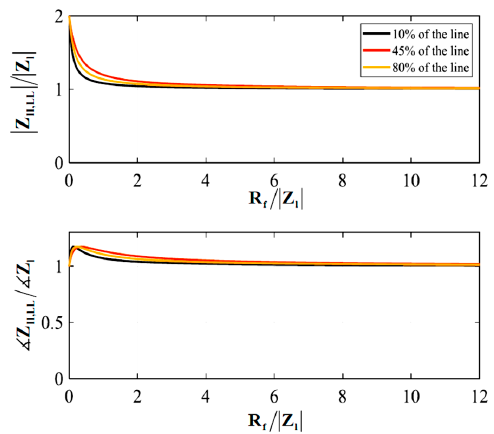
Figure 8. R f -Z I,LL curve for several fault location.